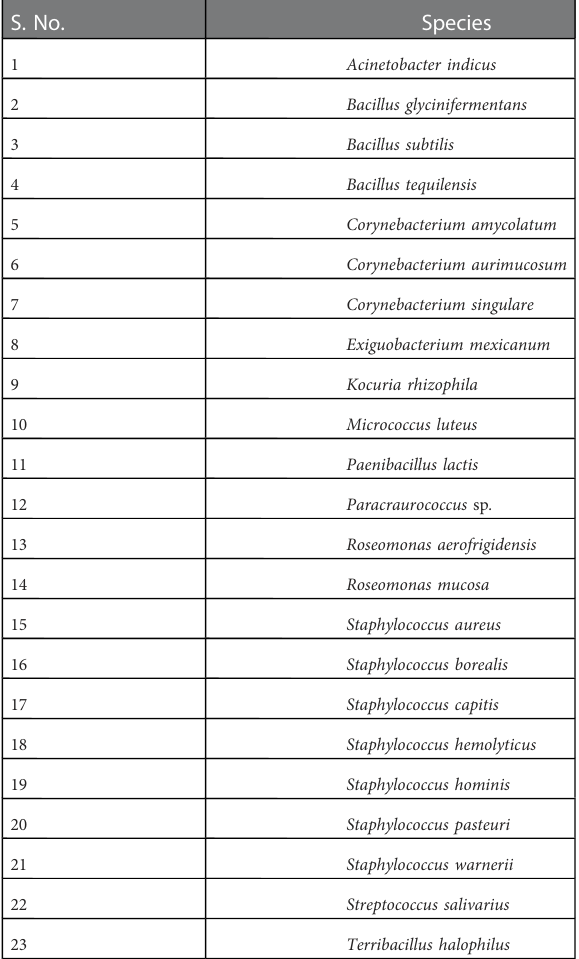
TABLE 1 Predominant microbial species in the DUWL identi fi ed by 16S rRNA gene sequencing. GenBank submission ID: 2641990. S.